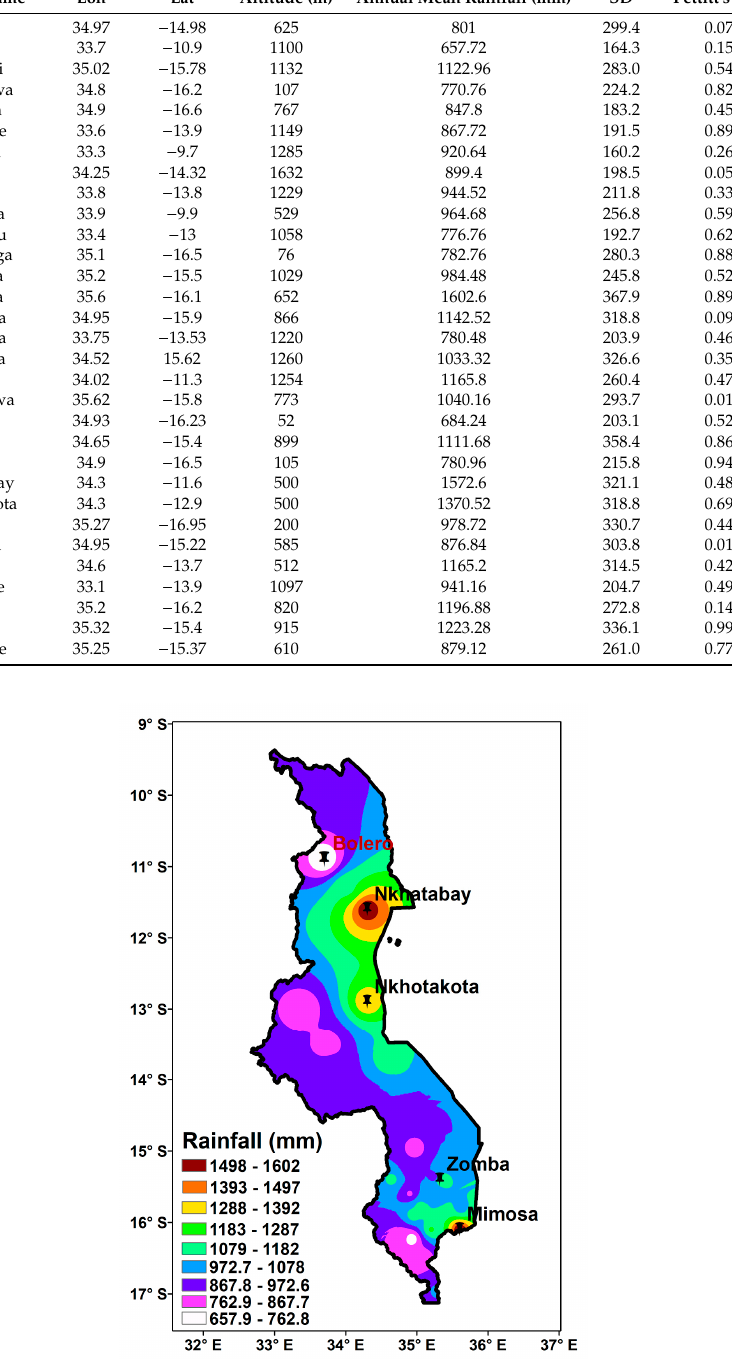
Figure 2. Distribution of annual mean rainfall over Malawi for the period 1979–2015. Stations in black font received high amounts of rainfall and a station in red font received the least amount of